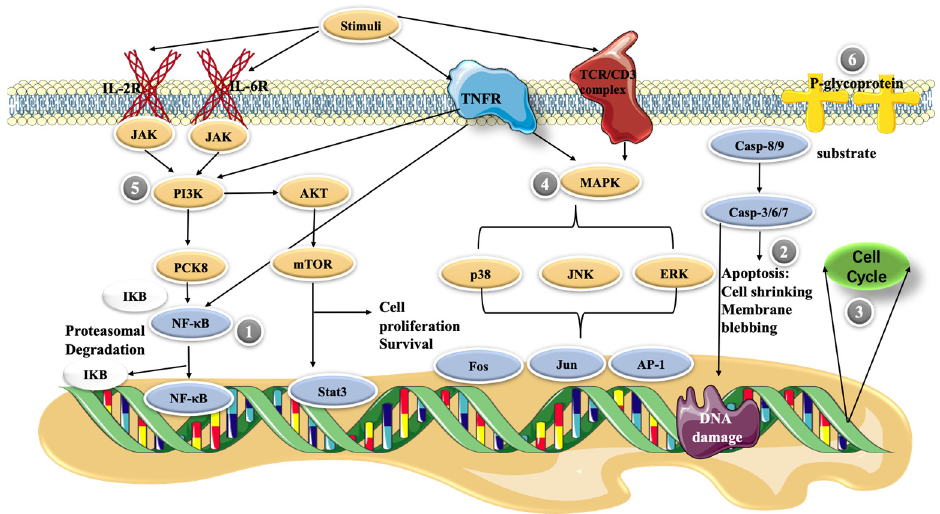
Figure 2. Possible molecular mechanisms of cepharanthine in cells. ( 1 ) NF ‐κ B pathway, ( 2 ) apopto ‐ sis, ( 3 ) cell cycle control, ( 4 ) MAPK pathway, ( 5 ) PI3K/Akt/mTOR signaling pathway, and ( 6 ) P ‐ glycoprotein